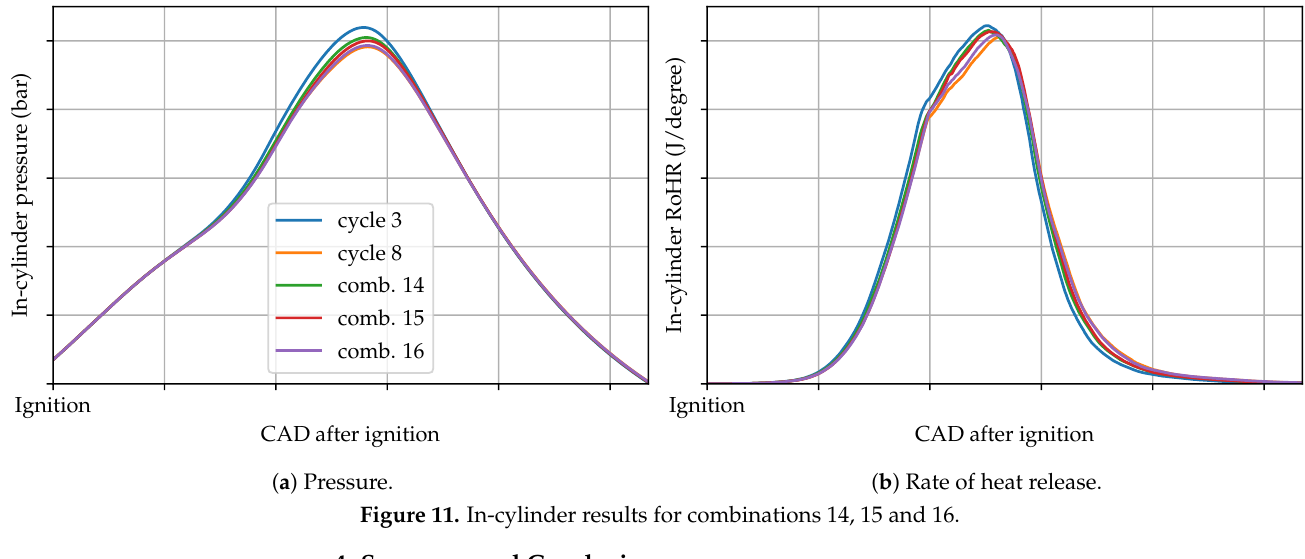
Figure 11. In-cylinder results for combinations 14, 15 and